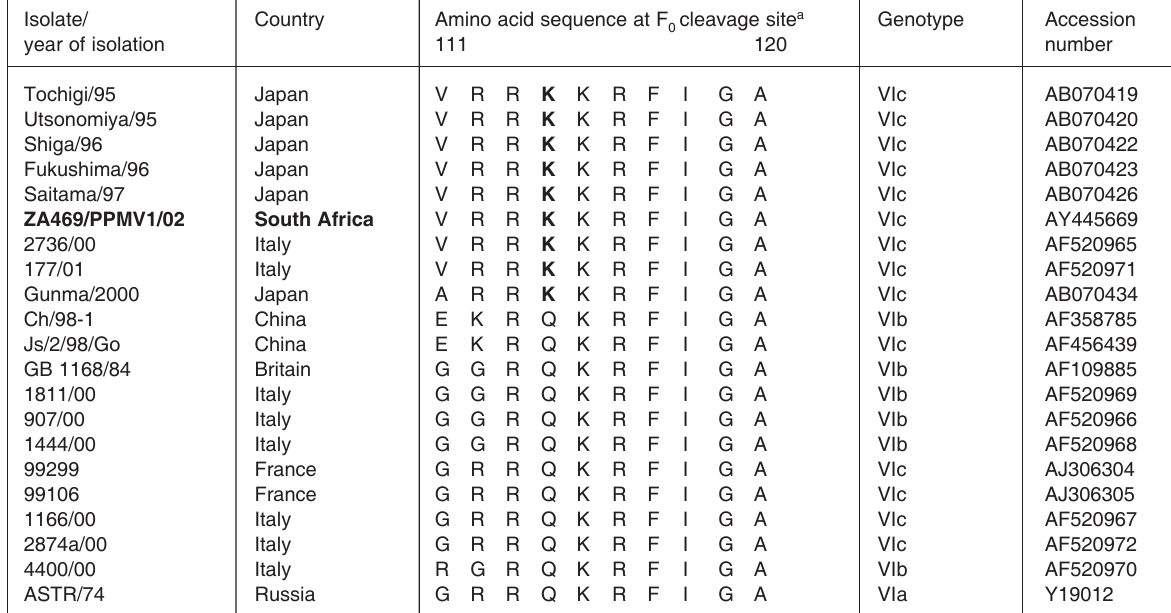
TABLE 1 Viruses used in the phylogentic analysis and comparison of F Isolate/ Country Amino acid sequence at F